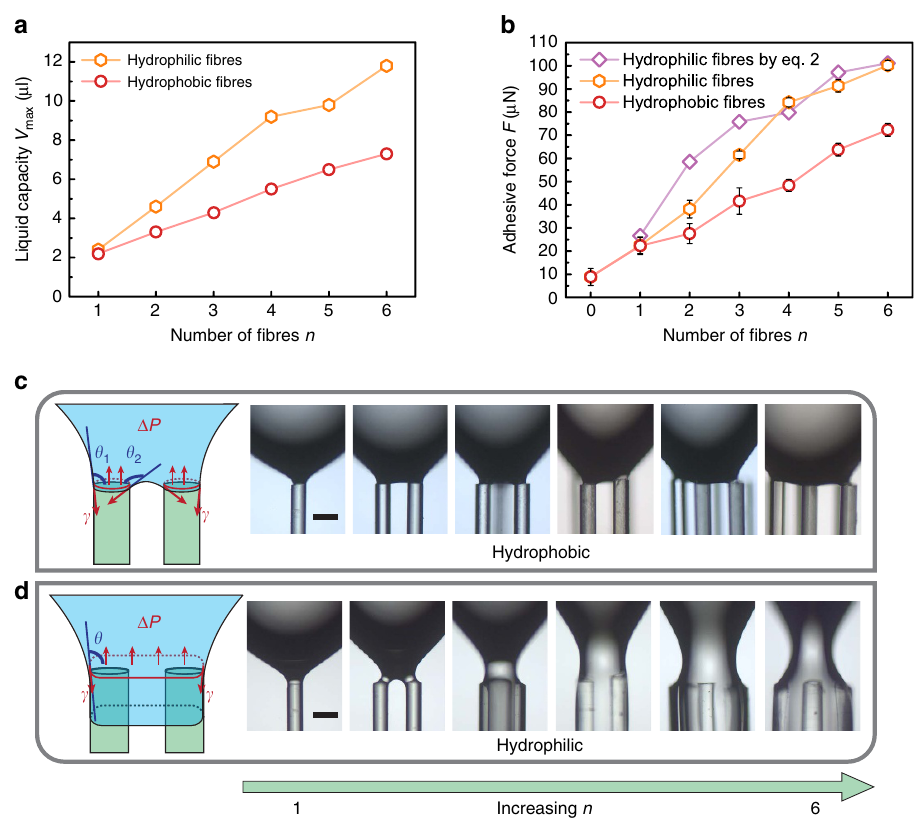
Figure 2 | The adhesive performance of the MRS. ( a ) The liquid capacity of an MRS increases as the number of regulating fibres increases. ( b ) The measured adhesive force of an MRS increases as the number of fibres increases. The red and orange lines represent the measured adhesion of MRSs with hydrophobic and hydrophilic fibres, respectively, based on ref. 26. The purple line represents the estimated adhesion of an MRS with hydrophilic fibres based on equation (2). The error bars indicate the standard deviations over five independent measurements. A series of optical microscopy images showing ( c ) the capillary bridges with receding contact lines on MRSs with numbers of hydrophobic fibres varying from 1 to 6 and ( d ) the thinning capillary bridges between the droplets and MRSs with numbers of hydrophilic fibres varying from 1 to 6. Scale bars, 200 m